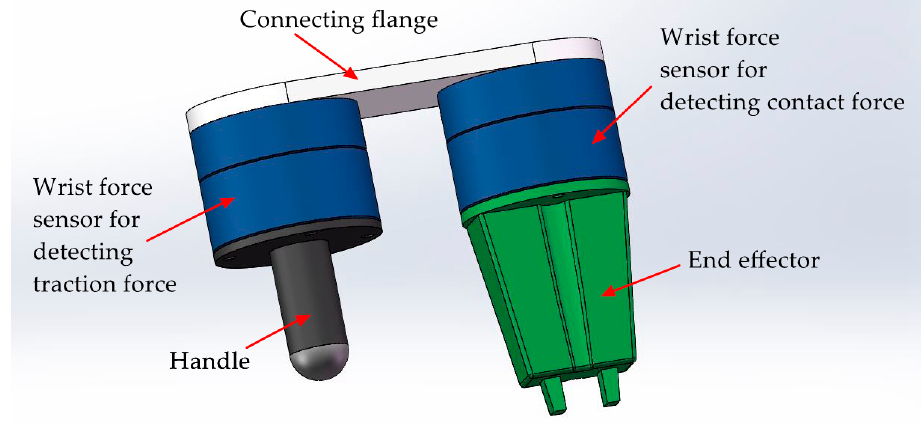
Figure 3. Two wrist force sensors installed in parallel for detecting the traction and contact forces.